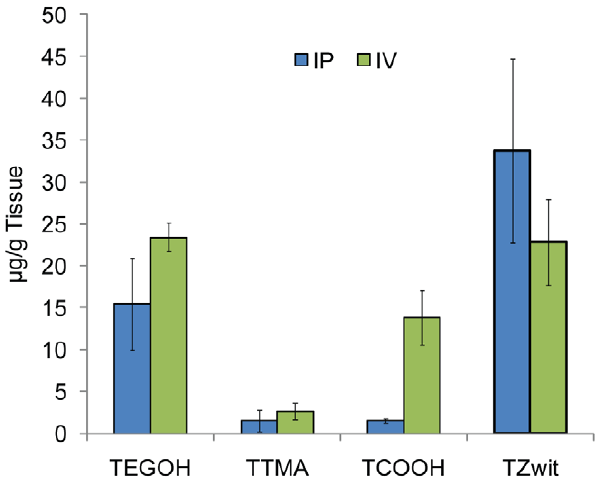
Figure 3. Quantification of in vivo accumulation of gold nanoparticles into tumors. Coinciding with the blood concentration, nanoparticles that showed a long retention time in circulation were able to extravasate and accumulate into the tumor. Data points are the mean + / 2 SEM from n=5 animals.